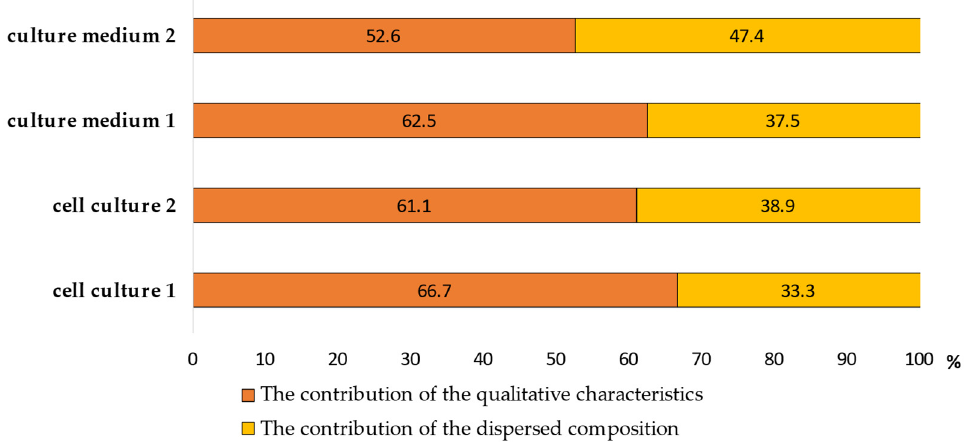
Figure 6. The proportion of the contribution of qualitative and dispersed composition to the cell response.